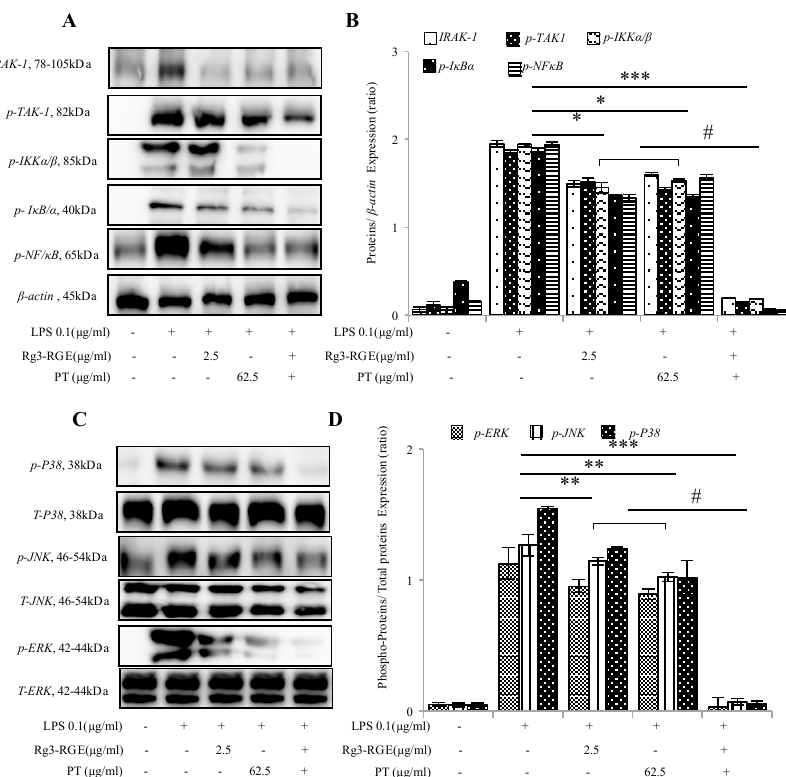
Figure 4. Signal transduction of Rg3-RGE + PT by the NF- κ B and MAPK pathways. RAW 264.7 cells were pre-incubated with Rg3-RGE + PT extract for 30 min and then stimulated with LPS for 18 h. Nuclear and cytosolic proteins from cells were extracted by NE-PER ® nuclear and cytosolic extraction reagents. β -actin was used as an internal control. Images are representative of three independent experiments. ( A , B ) NF- κ B pathway, and ( C , D ) MAPK pathway. Values in bar graphs represent mean ± SD of three independent experiments. *** p < 0.001, ** p < 0.05 and * p < 0.01 is considered significant compared to LPS and # p < 0.01 compared to inhibition by only Rg3-RGE or PT. Triplicates for Western blot analysis were completed within 3